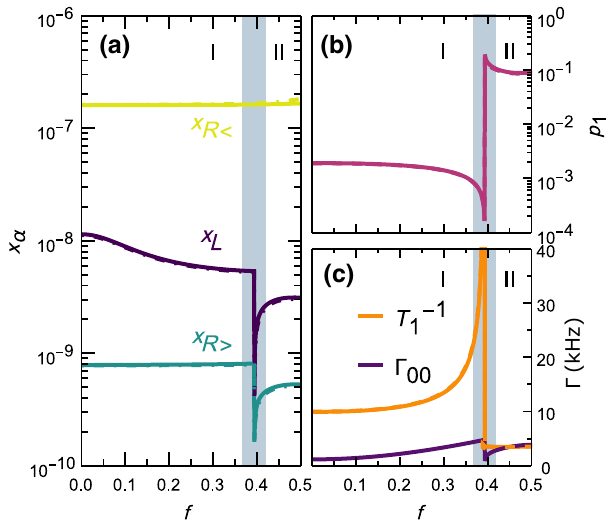
= 2 × 2.5 g ν = 0.73 × 0 K , T FIG. 10. The qubit-quasiparticle steady state versus the nor- malized flux for a split transmon. (a) The quasiparticle densi- ties in the steady state. (b) The excited-state population of the qubit. (c) The qubit inverse relaxation time and parity-switching rate in the steady state. Parameters: (cid:2) L / h = 52 GHz, (cid:2) R / h = = 2 × 2.5 g = 20 mK, 48 GHz, ω 10 ( 0 )/( 2 π) = 7 GHz, g (cid:17) K , T qp T = V = 940 μ m 3 , ν = 0.73 × 10 47 J − 1 m − 3 (cid:12) ph = 10 Hz, V 0 L R